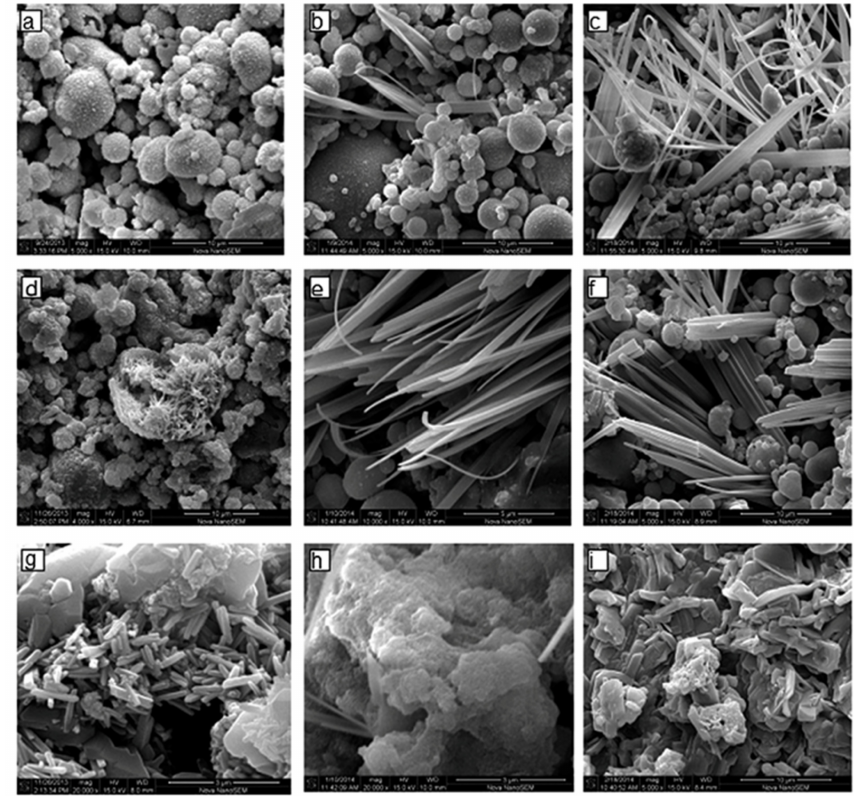
Figure 8. SEM pictures of FA-based geopolymers considering different process conditions (al- kali solution molarity and curing temperature): ( a ) 6 M—27 ◦ C; ( b ) 6 M—45 ◦ C; ( c ) 6 M—60 ◦ C; ( d ) 8 M—27 ◦ C; ( e ) 8 M—45 ◦ C; ( f ) 8 M—60 ◦ C; ( g ) 10 M—27 ◦ C; ( h ) 10 M—45 ◦ C; and ( i ) 10 M 60 ◦ C. Reprinted with permission from Ref. [50]. Copyright 2016